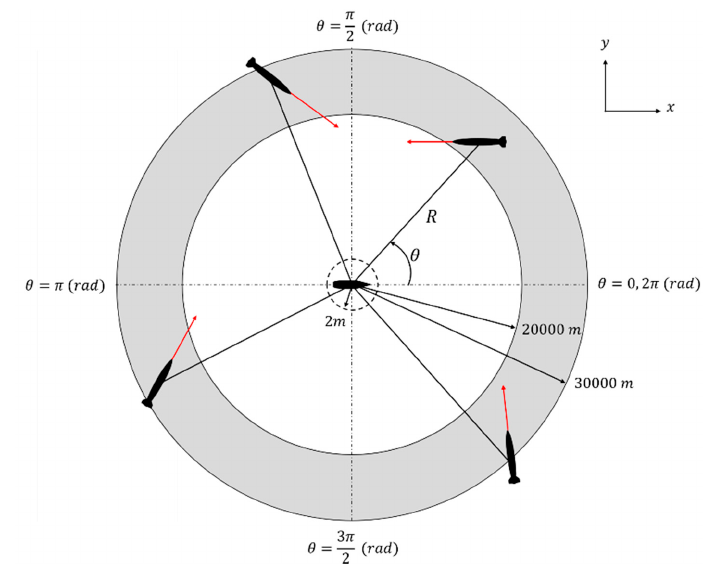
Figure 2. Missile–target engagement scenario. Table 1. Initial conditions of the missile.